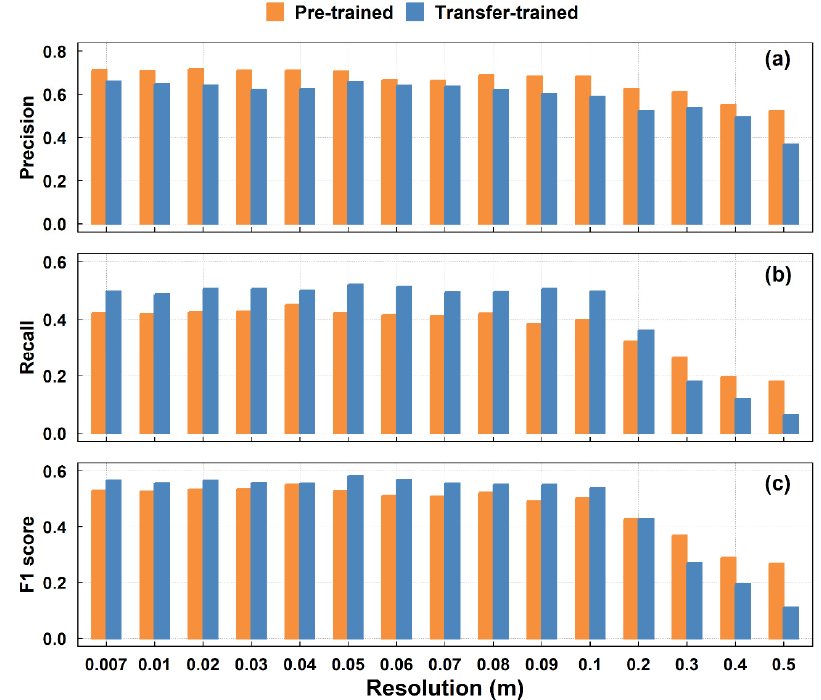
Figure 6. The effects of spatial resolution on the evaluation of tree crown detection from UAV-based RGB imagery using the pre- and transfer-trained Detectree2 methods as illustrated by the precision ( a ), recall ( b ), and F1 score ( c ).